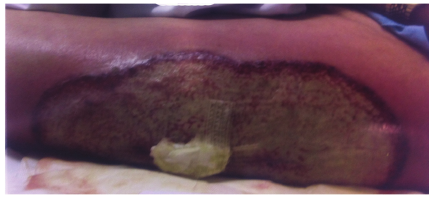
Figure 1: PG at DHS wound